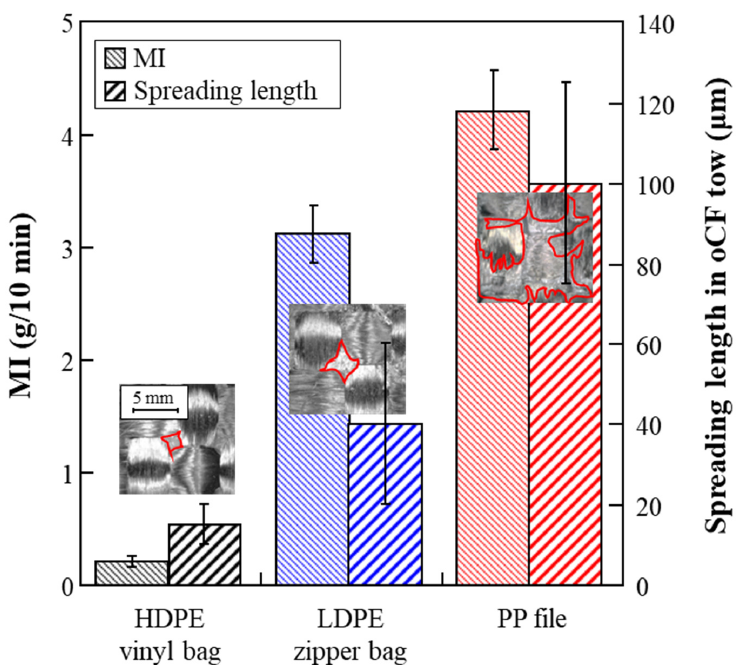
Figure 3. Melting indices (MIs) and spreading properties of three olefin resins: HDPE, LDPE, and PP.